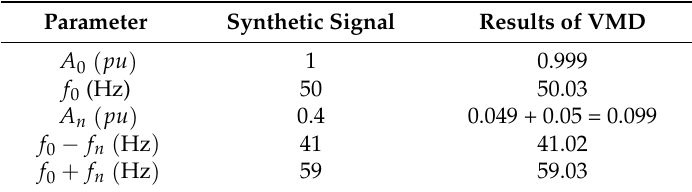
Table 2. Results of VMD for flicker